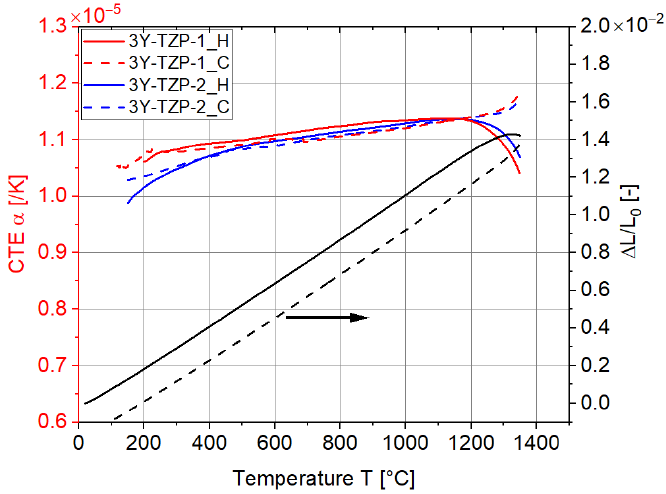
Figure 3. Length changes in specimen 1 and technical CTE results for 3Y-TZP during both heating (H) and cooling (C) steps.